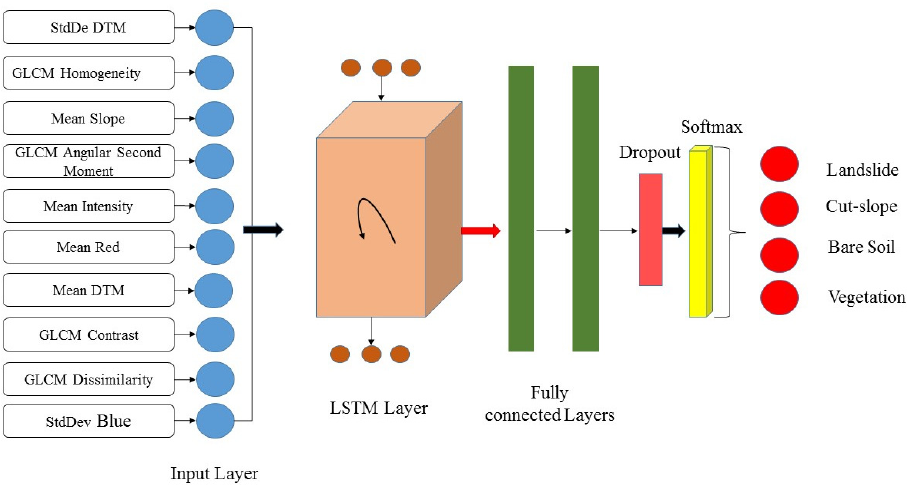
Figure 7. Architecture of the RNN model.